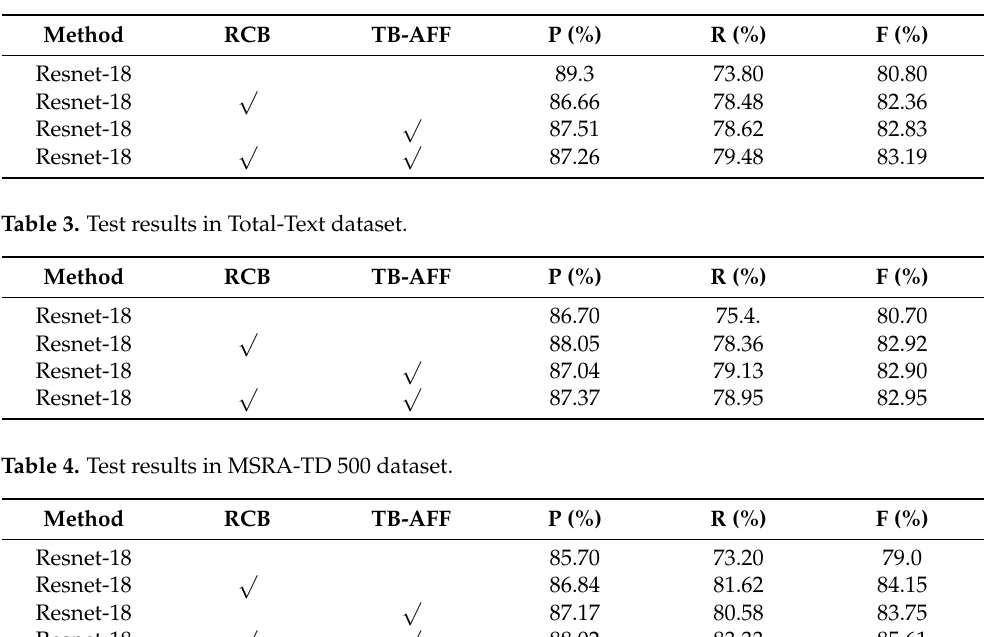
Table 2. Test results in ICDAR 2015 dataset.